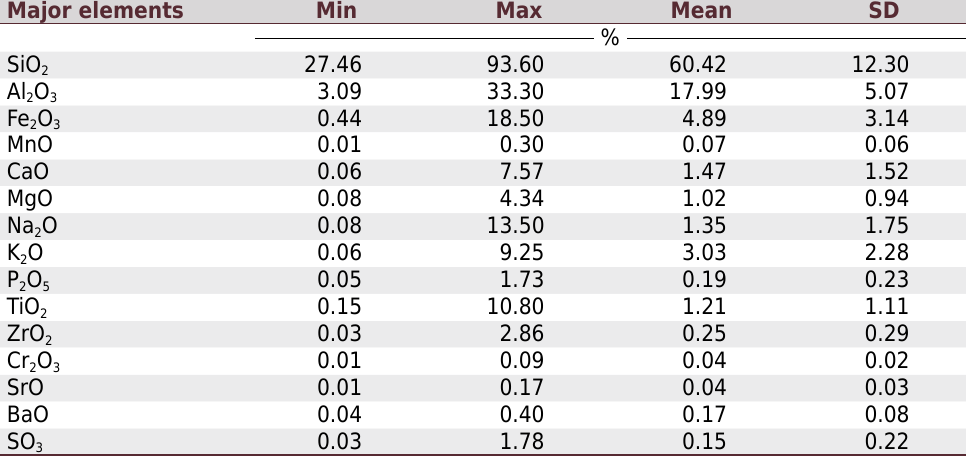
Table 3. Mean, minimum, maximum, and standard deviation for the major elements in Rio Grande do Norte soils